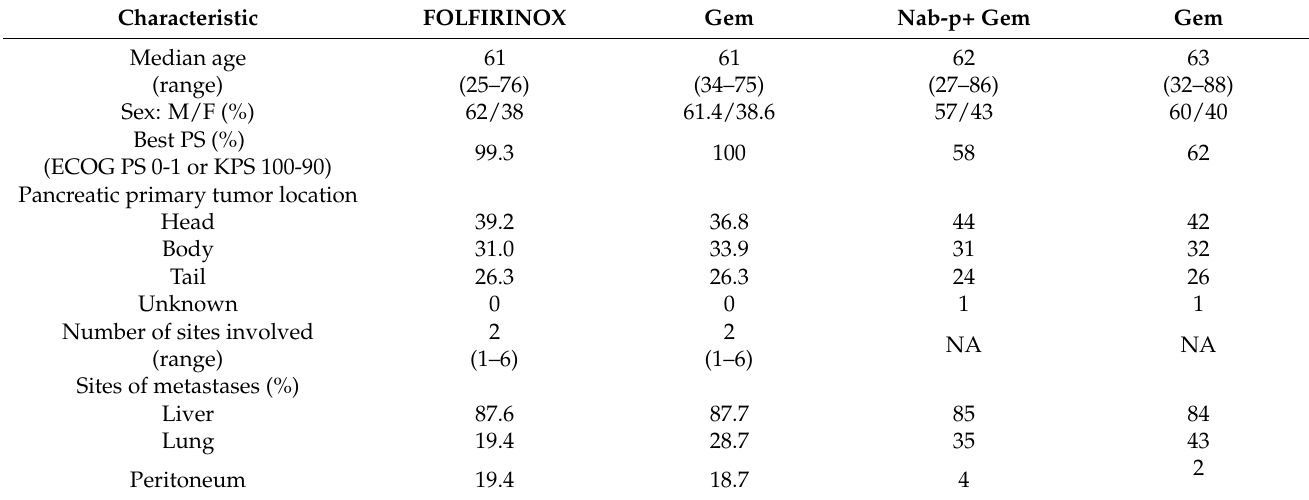
Table 2. Principal characteristics of patients included in FOLFIRINOX and MPACT